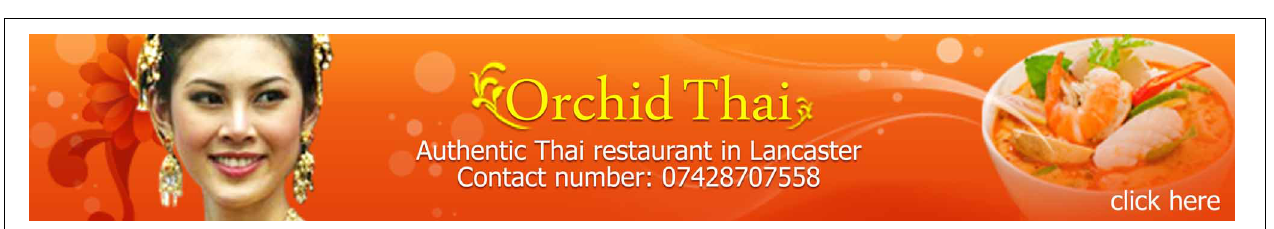
FIGURE 8 | Fabricated horizontal banner advertisement for “Orchid Thai” in the averted gaze